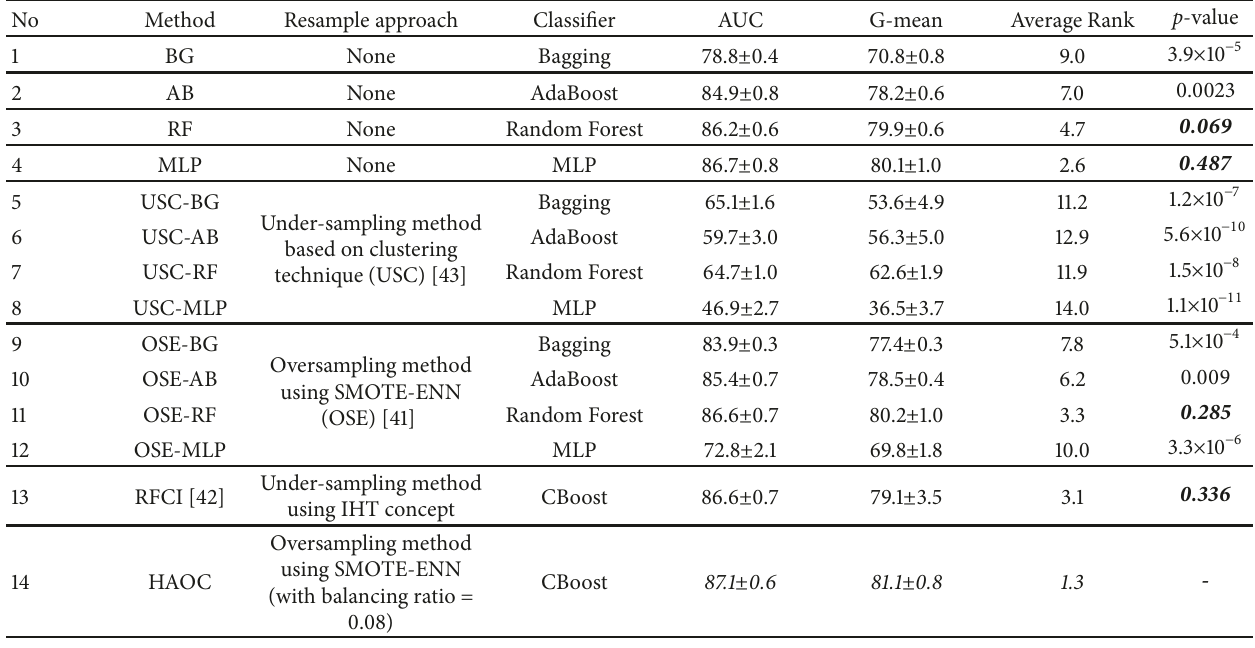
Table 3: The overall results of all experimental approaches for KRBDS.